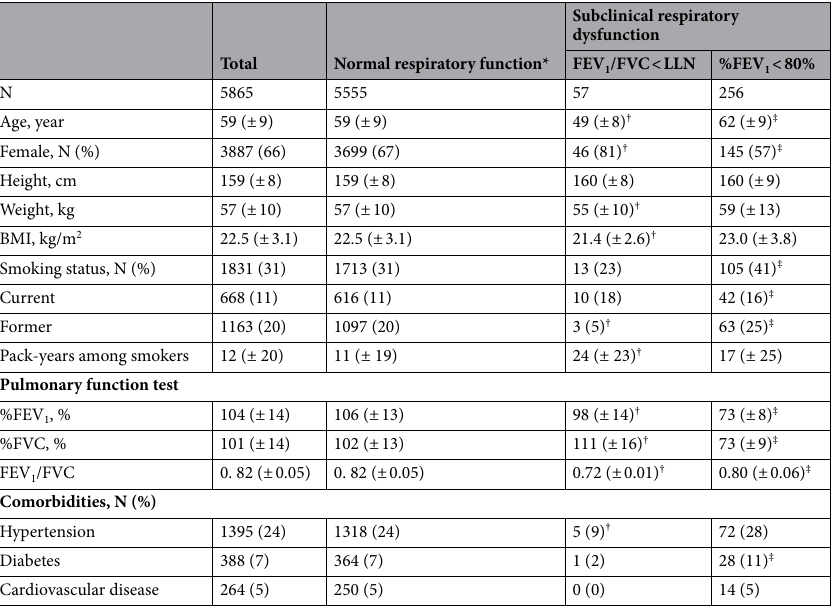
Table 1. Characteristics of the subjects without AFL or dyspnoea on exertion at enrolment (N = 5865). All values are expressed as the mean (± SD) except categorical variables, which are expressed as N (%). SD